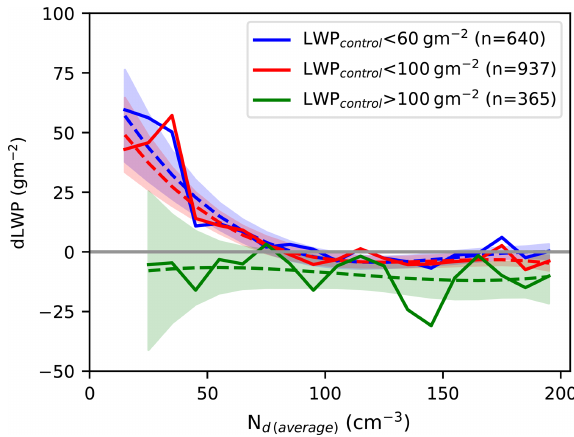
Figure 6. The difference in the LWP between the ship track and surrounding control regions as a function of the ship track N d . The separate lines are for different values of control LWP. The LWP and N d values are from MODIS, using the ship track dataset from Christensen et al. (2014). The numbers in the legend are the number of ship tracks that make up each line. Each line is characterised by a third-order uncertainty-weighted polynomial fit (dashed), with the shaded area showing the 2 σ uncertainty on the